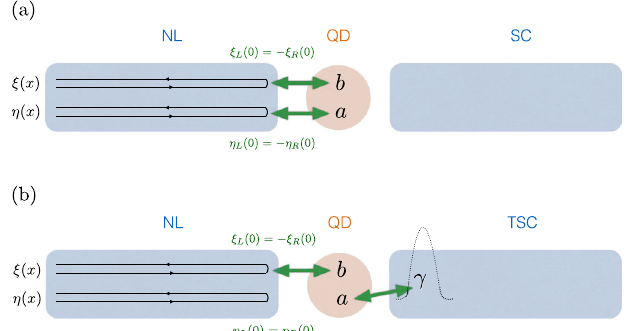
FIG. 4. Cartoon representation of the low-energy fixed points (large-time behavior) for a simplified spinless NL-QD-(T)SC junction with a noninteracting lead and a superconductor in a trivial (a) or topological (b) phase. When the superconductor is in a topological phase, the Majorana zero mode at its edge becomes hybridized with “ half ” of the quantum dot, by decomposing the dot fermion as d ¼ ð a þ ib Þ = 2 . As a result, only one of the two Majorana channels in the normal lead ψ ð x Þ ¼ ( ξ ð x Þ þ i η ð x Þ ) = 2 experiences a π = 2 phase shift corresponding to Andreev reflec- tion ψ † ð 0 Þ ¼ ψ L ð 0 Þ at the junction. This has crucial conse- R quences on the dynamics after a local quantum quench of the tunneling between the dot and the normal